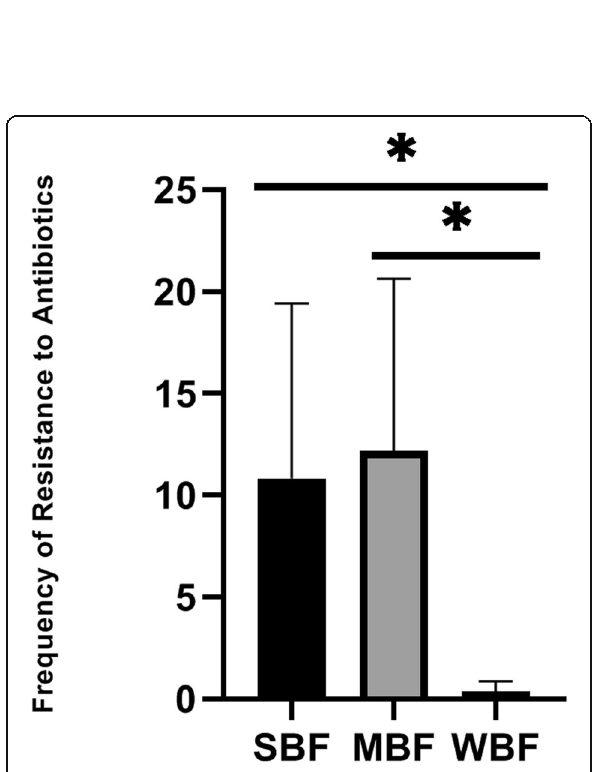
Fig. 3 Biofilm forming potential and antibiotic resistance frequency. Values are expressed as means±SD, * P <